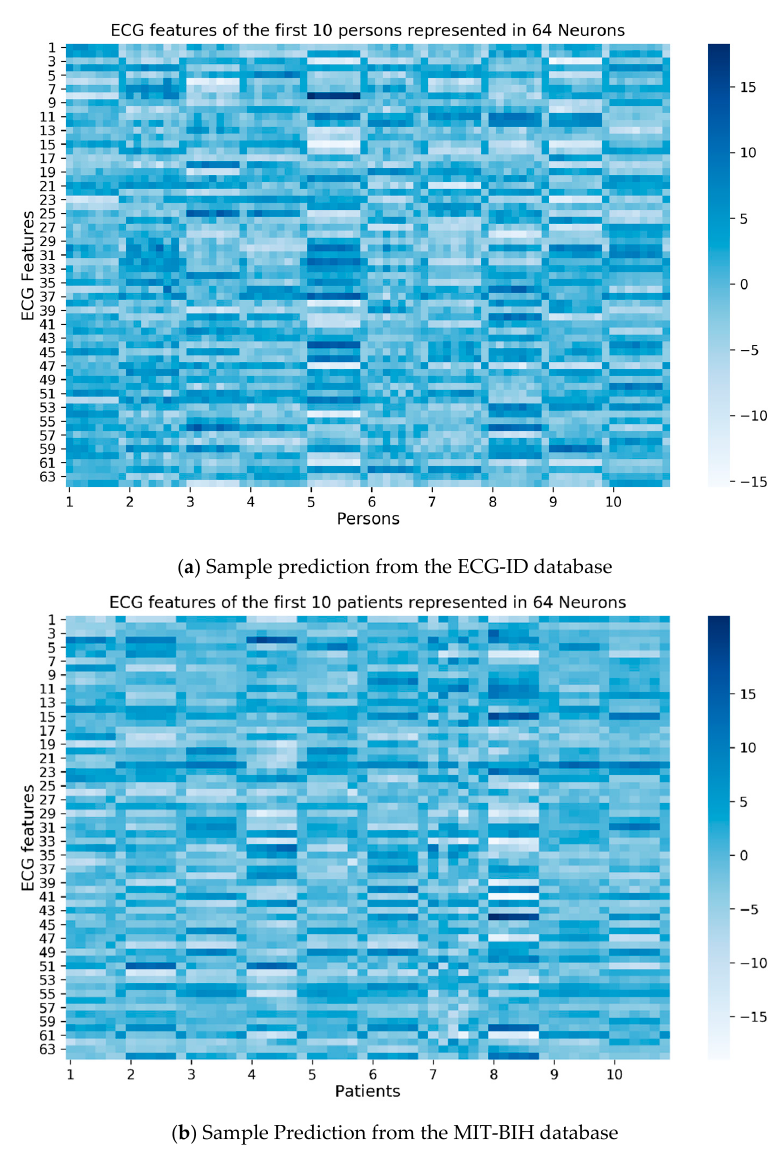
Figure 4. Eight ECG beats feature from 10 people represented by 64 neurons of the fully connected layer (layer 27, Table 2).